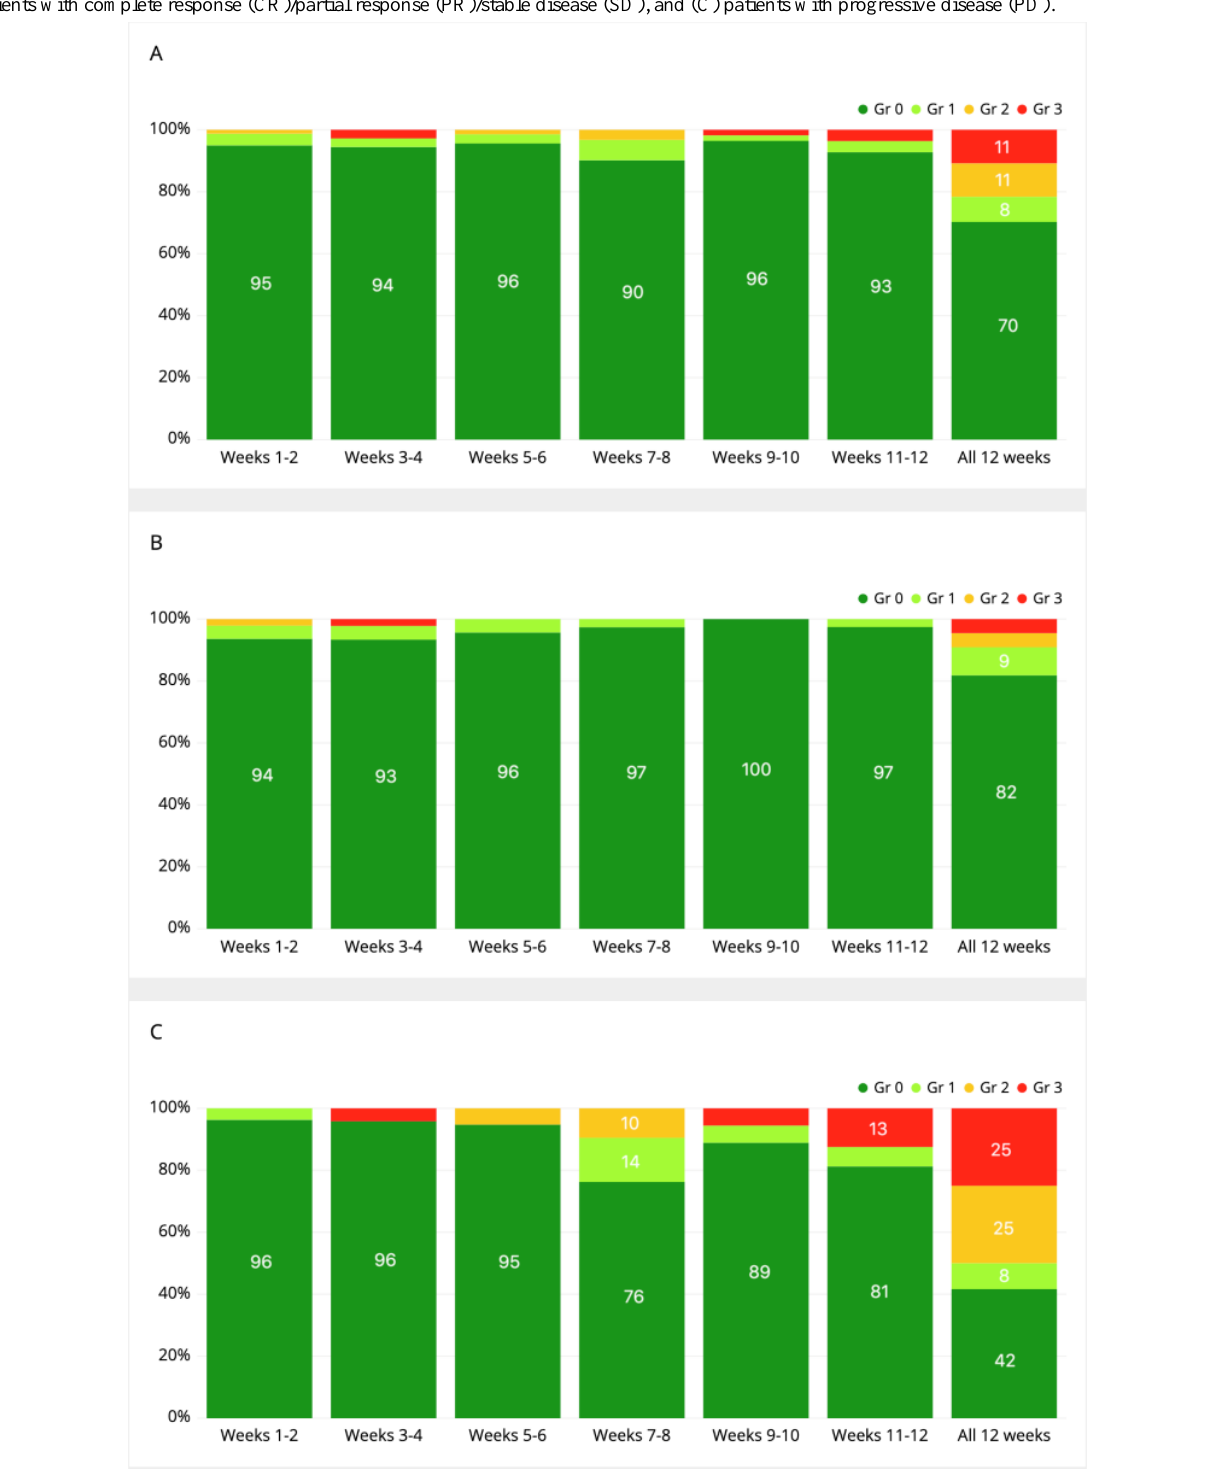
Figure 4. Distribution of the symptom grades reported on the symptom questionnaires during the first 12 weeks for chest pain for (A) all patients, (B) patients with complete response (CR)/partial response (PR)/stable disease (SD), and (C) patients with progressive disease